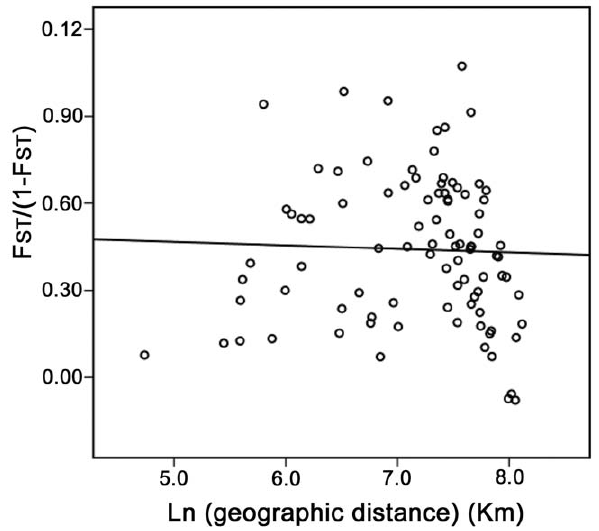
Figure 4. Correlation between pairwise linearzed F ST values and the logarithm of geographic distance in Chinese popula- tions of Frankliniella occidentalis. Reduced Major Axis (RMA) regression line is shown.